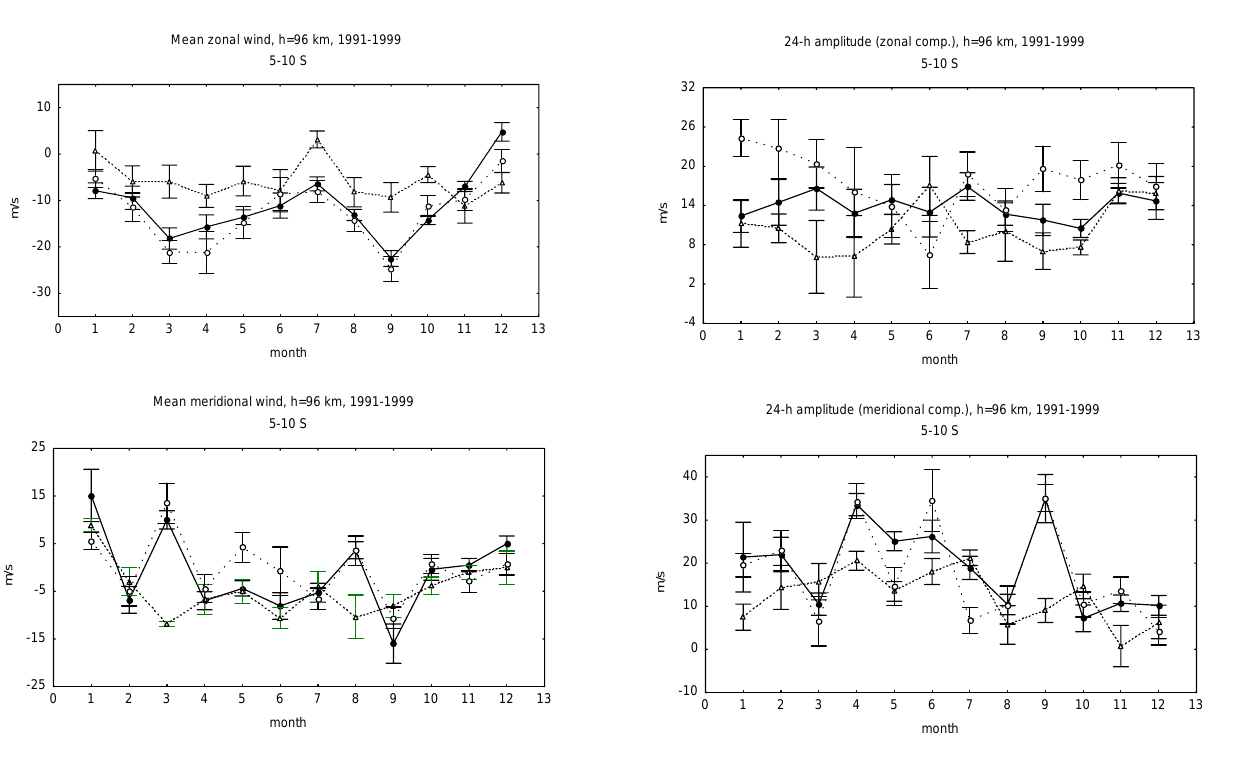
Fig. 17. Same as Fig. 16, except for amplitude of diurnal